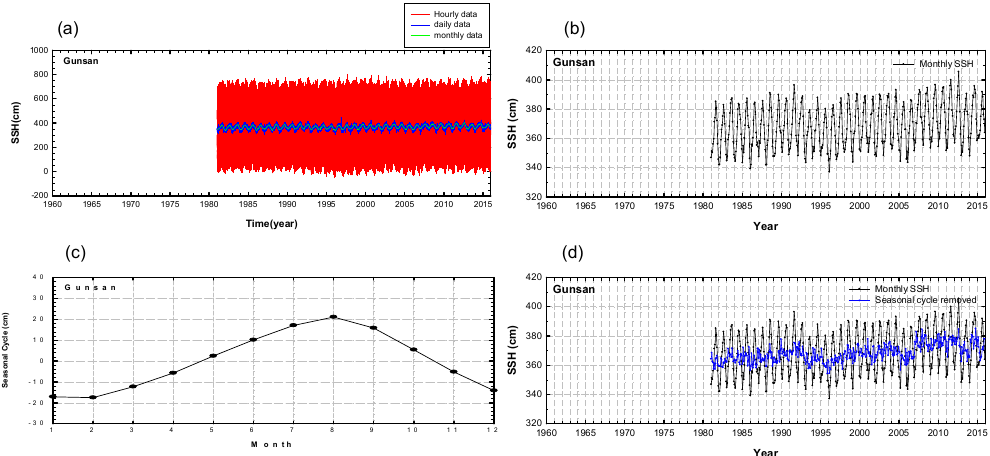
Figure 2. The observed sea level data at the Gunsan tide gauge data: ( a ) hourly, daily, and monthly sea level data; ( b ) monthly seal level data; ( c ) seasonal cycle of sea level; and ( d ) monthly sea level data with no seasonal components. SSH is the sea surface height.